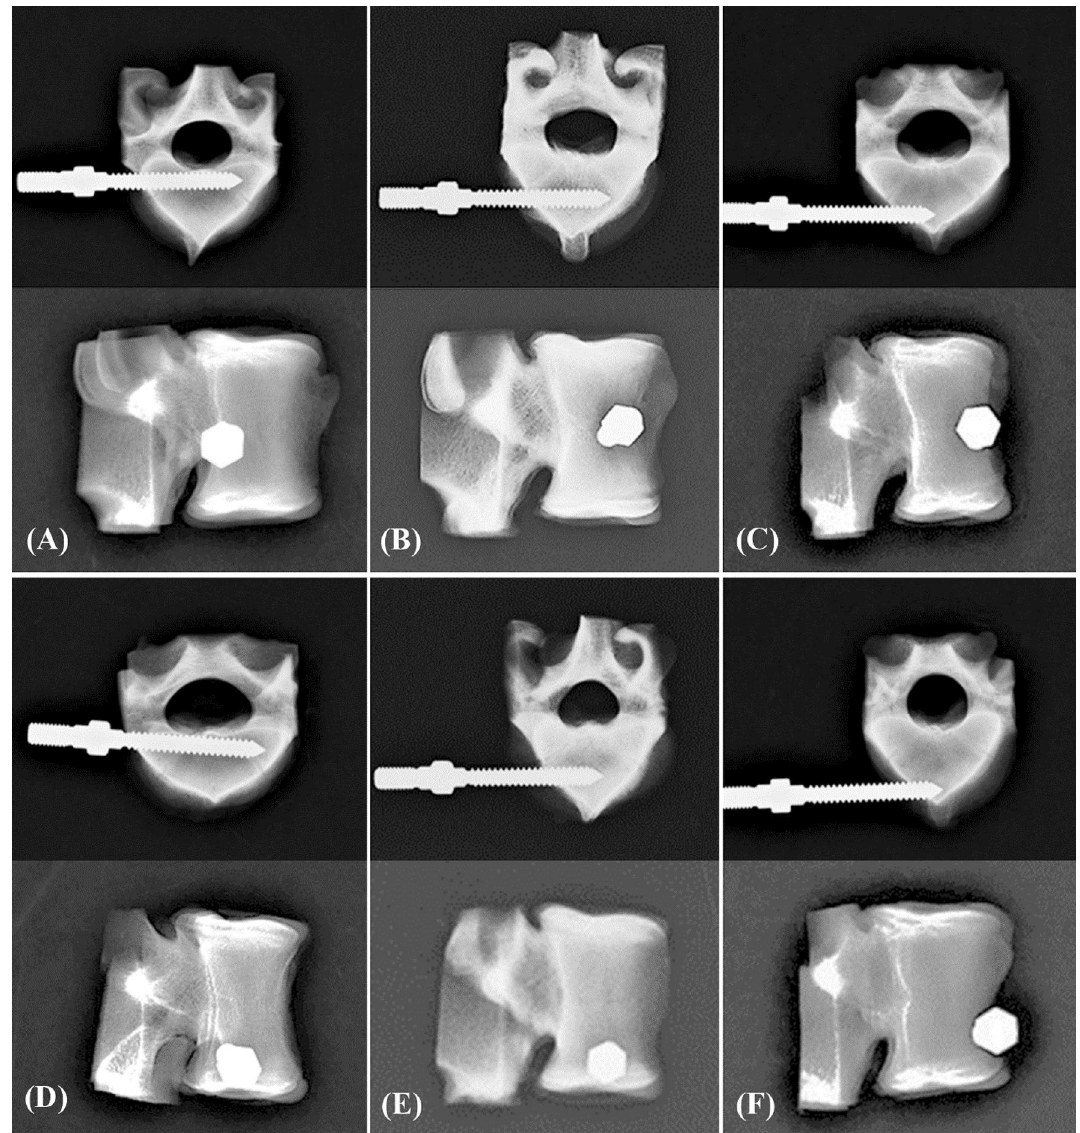
Figure 4. Axial (upper) and sagittal (bottom) X-ray images of the unicortical fixation modality showing the porcine vertebrae with various insertion positions. ( A ) C-p, ( B ) C-m, ( C ) C-a, ( D ) L-p, ( E ) L-m, and ( F )